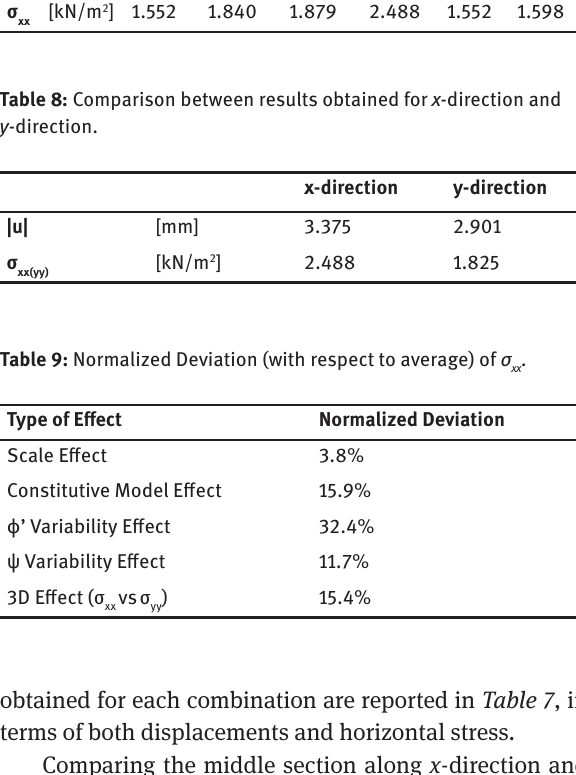
Table 8: Comparison between results obtained for x -direction and y -direction.